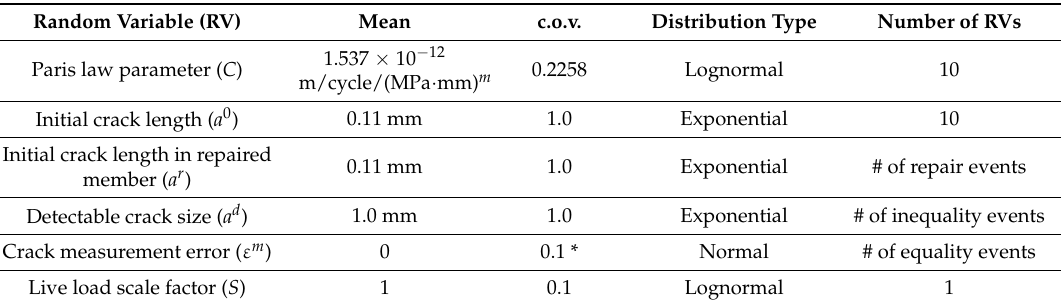
Table 2. Statistical properties of random